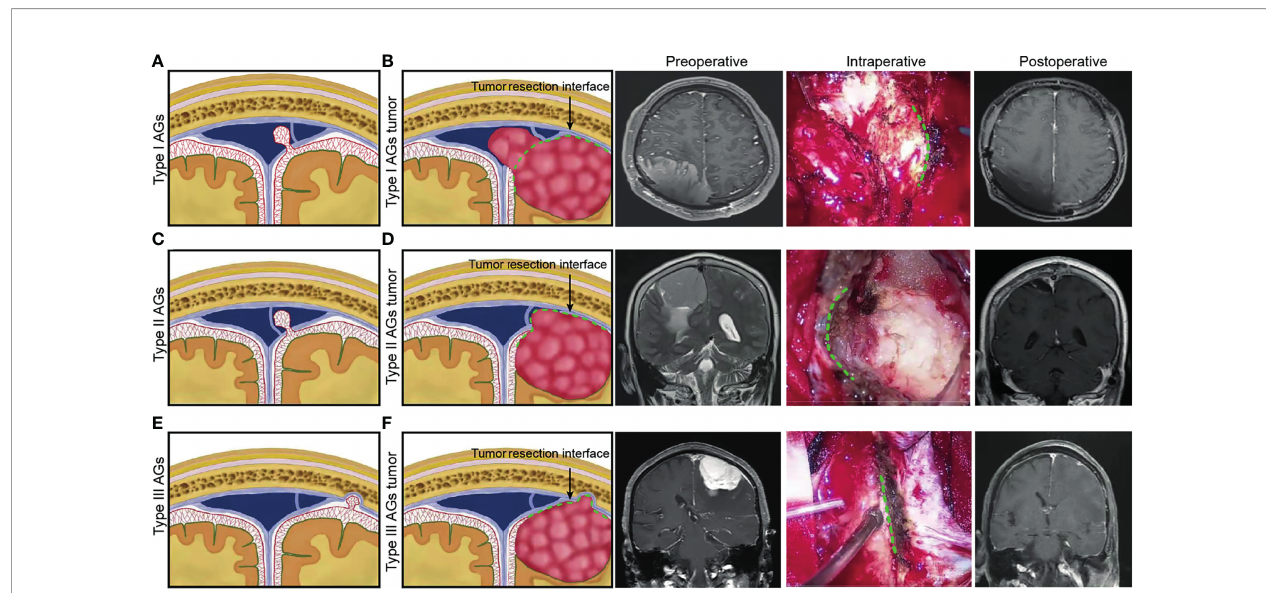
FIGURE 6 | For different anatomical type of arachnoid granulation, schematic diagram illustrating the hypothesized different growth patterns of parasagittal meningioma was presented. Preoperative, intraoperative and postoperative pictures of different types of meningioma were used to illustrate the type of tumor origin and the interface for maximum safe resection of tumors during operation. (A) Type I AGs. (B) tumor growth patterns of Type I AGs and tumor resection interface (green dotted line) during surgery. (C) Type II AGs. (D) tumor growth patterns of Type II AGs and tumor resection interface (green dotted line). (E) Type III AGs. (F) tumor growth patterns of Type III AGs and tumor resection interface (green dotted